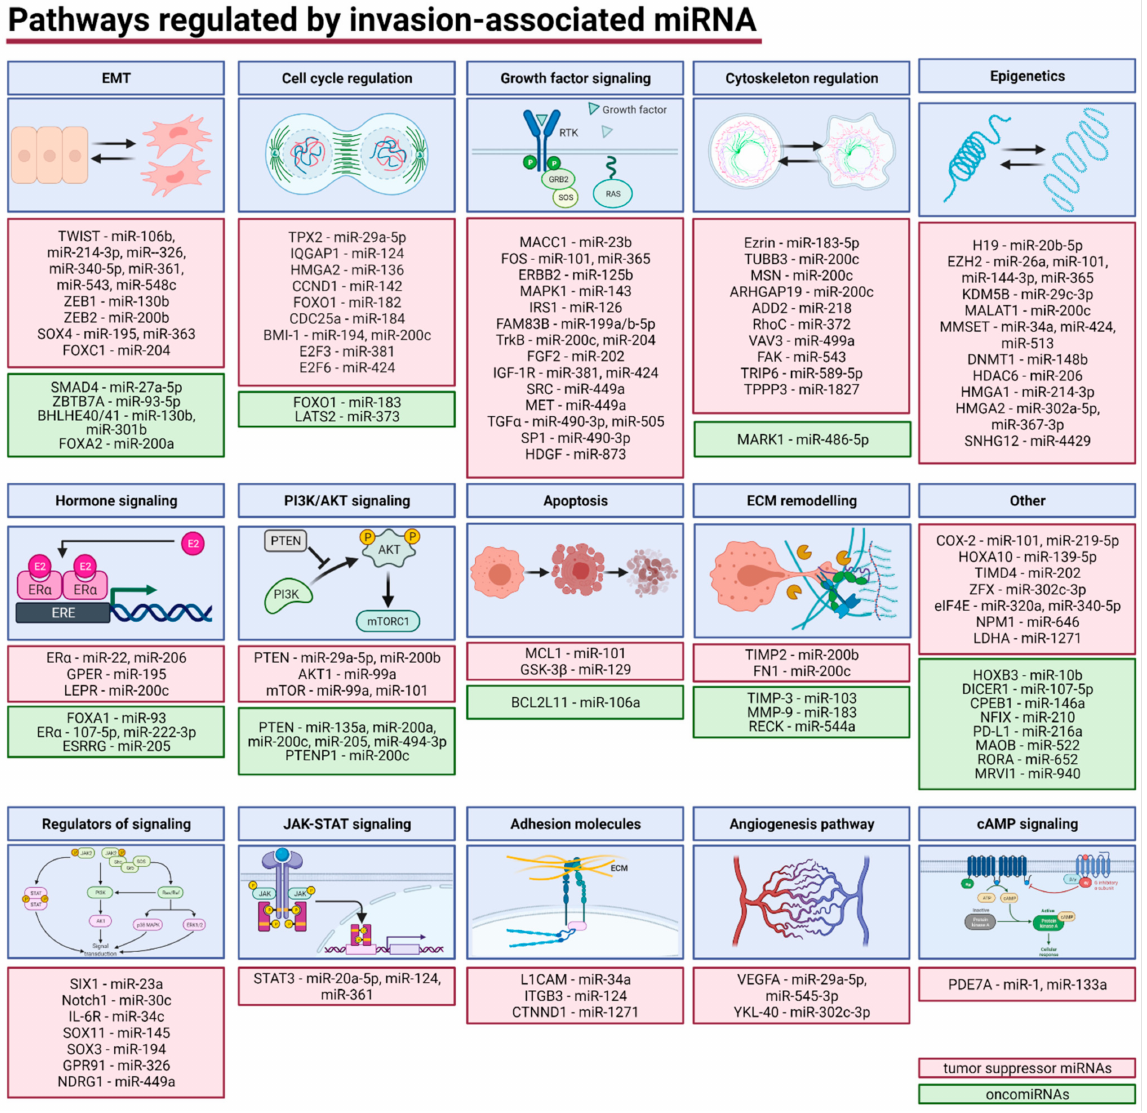
Figure 4. Direct targets of invasion-regulating miRNAs. cAMP—Cyclic Adenosine Monophosphate, EMT—epithelial– mesenchymal transition, ECM—extracellular matrix, JAK-STAT—Janus Kinase/Signal Transducers and Activators of Transcription, PI3K/AKT—Phosphatidylinositol 3-Kinase/Protein Kinase B. Figure was created using